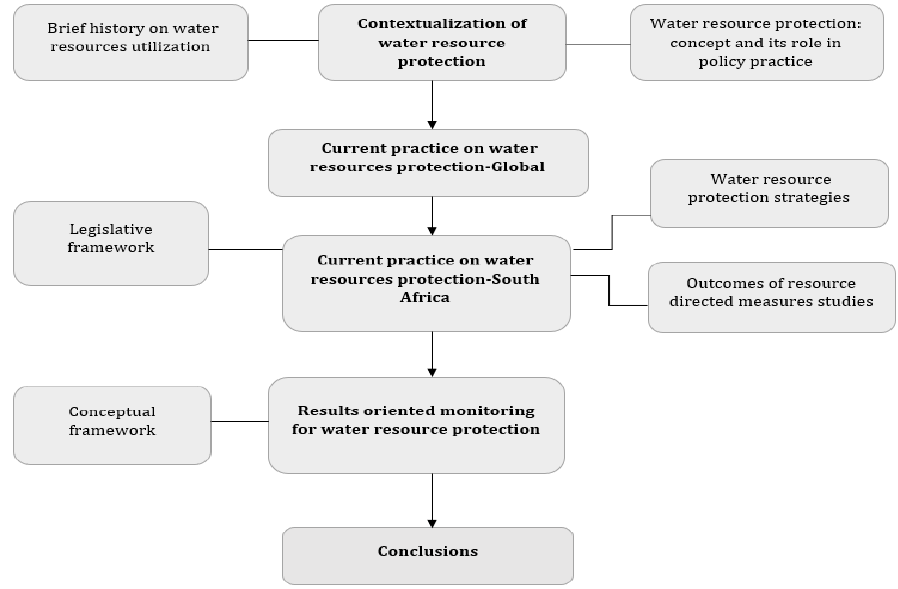
Figure 1. Research approach (Methodology).